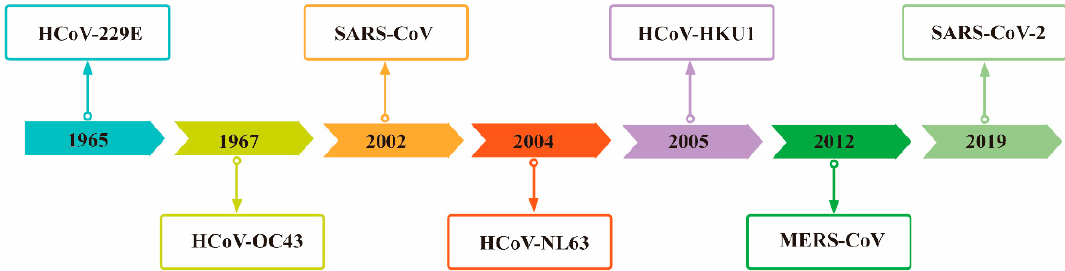
Figure 1. Chronological order of seven coronaviruses capable of infecting humans.